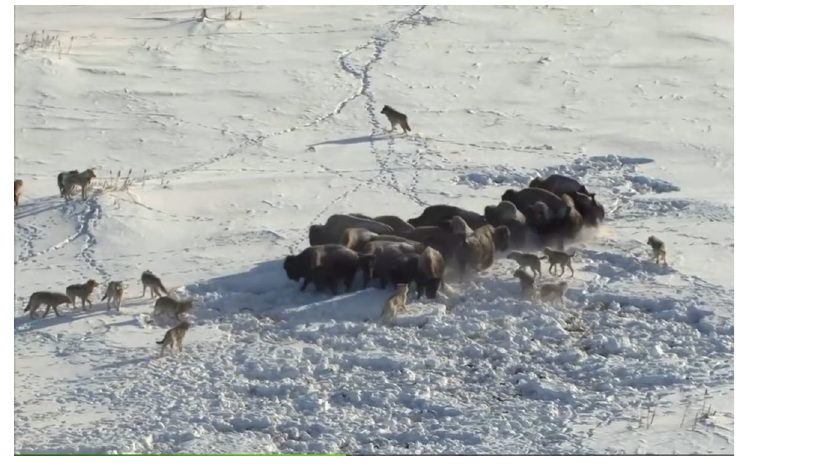
Fig 2. The hunting process of grey